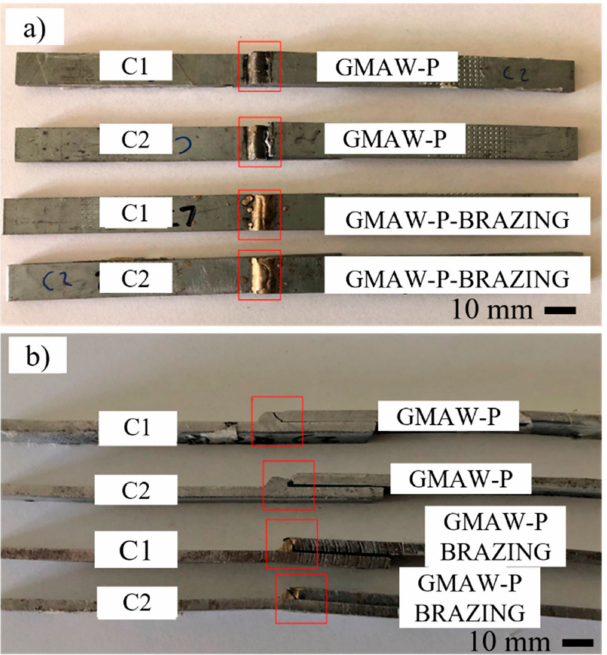
Figure 10. Macrographs of the lap welded joints for pulsed and pulsed-brazing specimens after tensile testing: ( a ) top view and ( b ) transverse view.